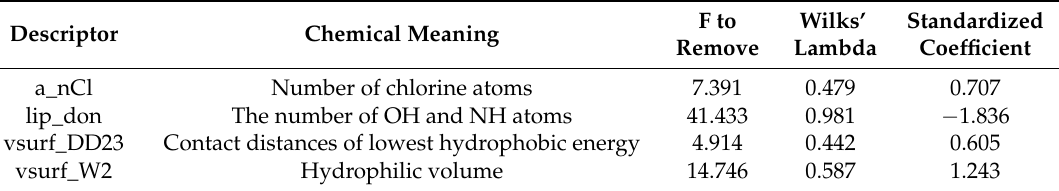
Table 2. The correlation matrix of descriptors. Table 1. Molecular descriptors and the standardized coefficient of the LDA model.